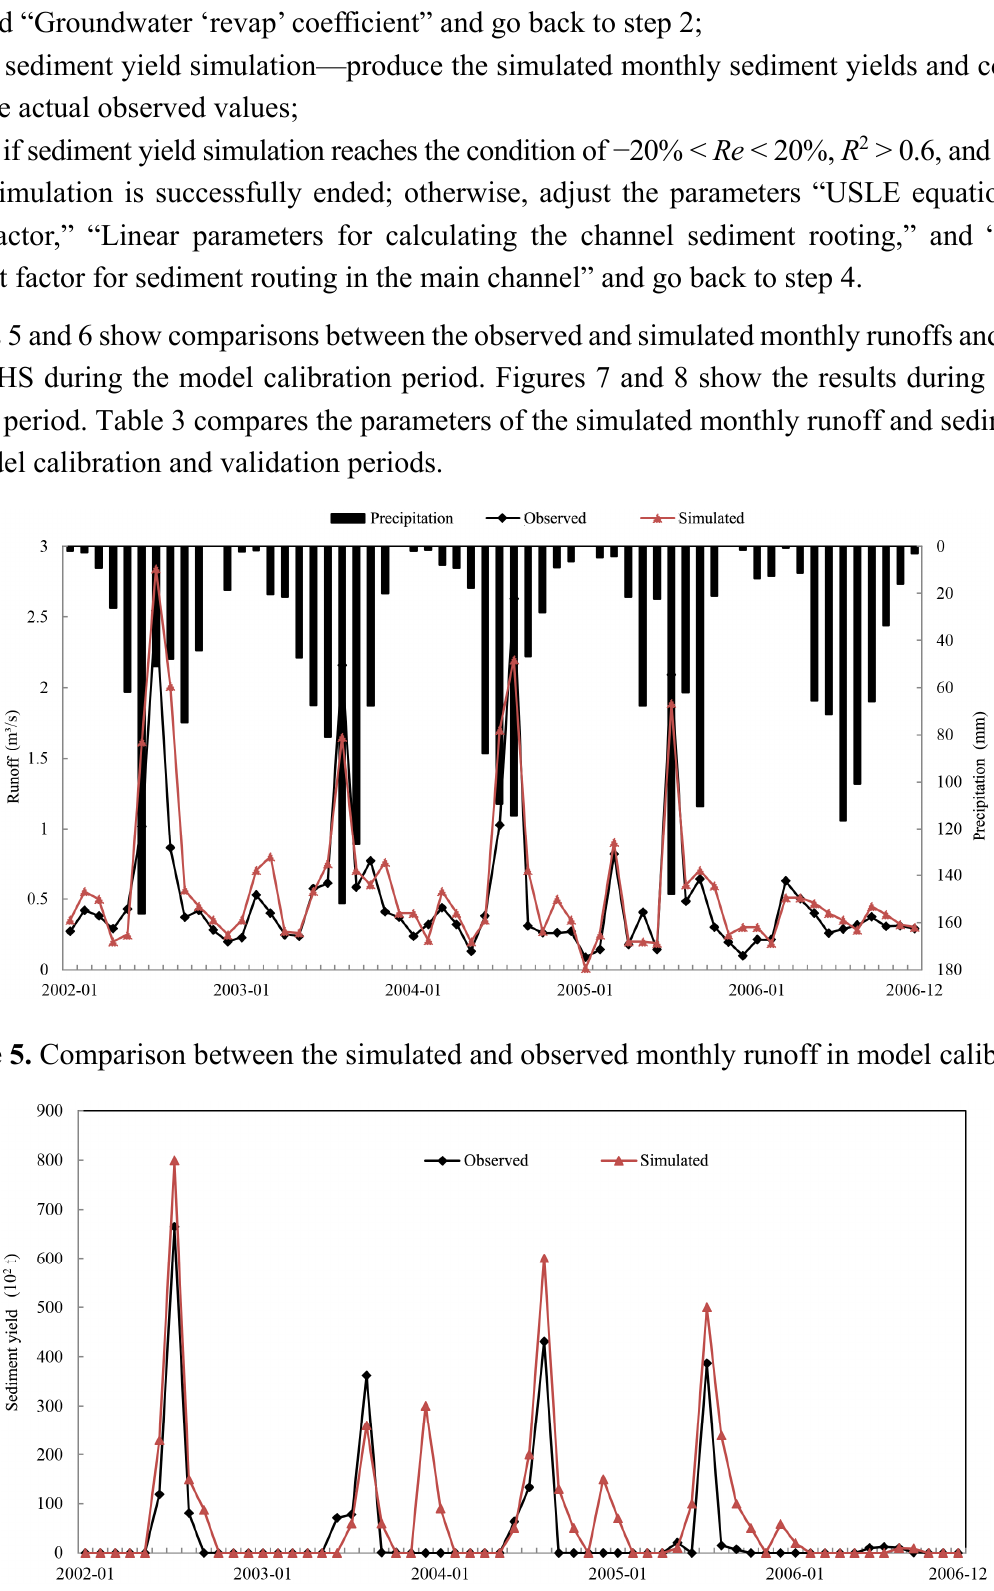
Figure 6. Comparison between the simulated and observed monthly sediment yield in model